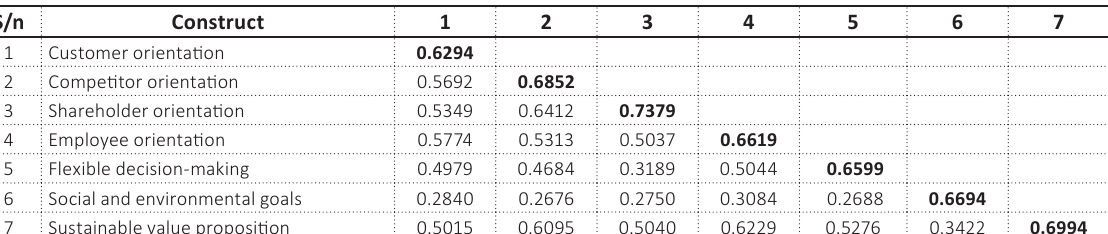
Table 4. Test of discriminant validity (Fornell-Larcker criterion)